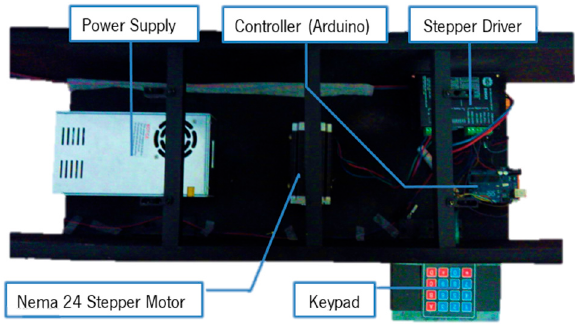
Figure 7. Tensioned elements mechanism prototype and electronic components.